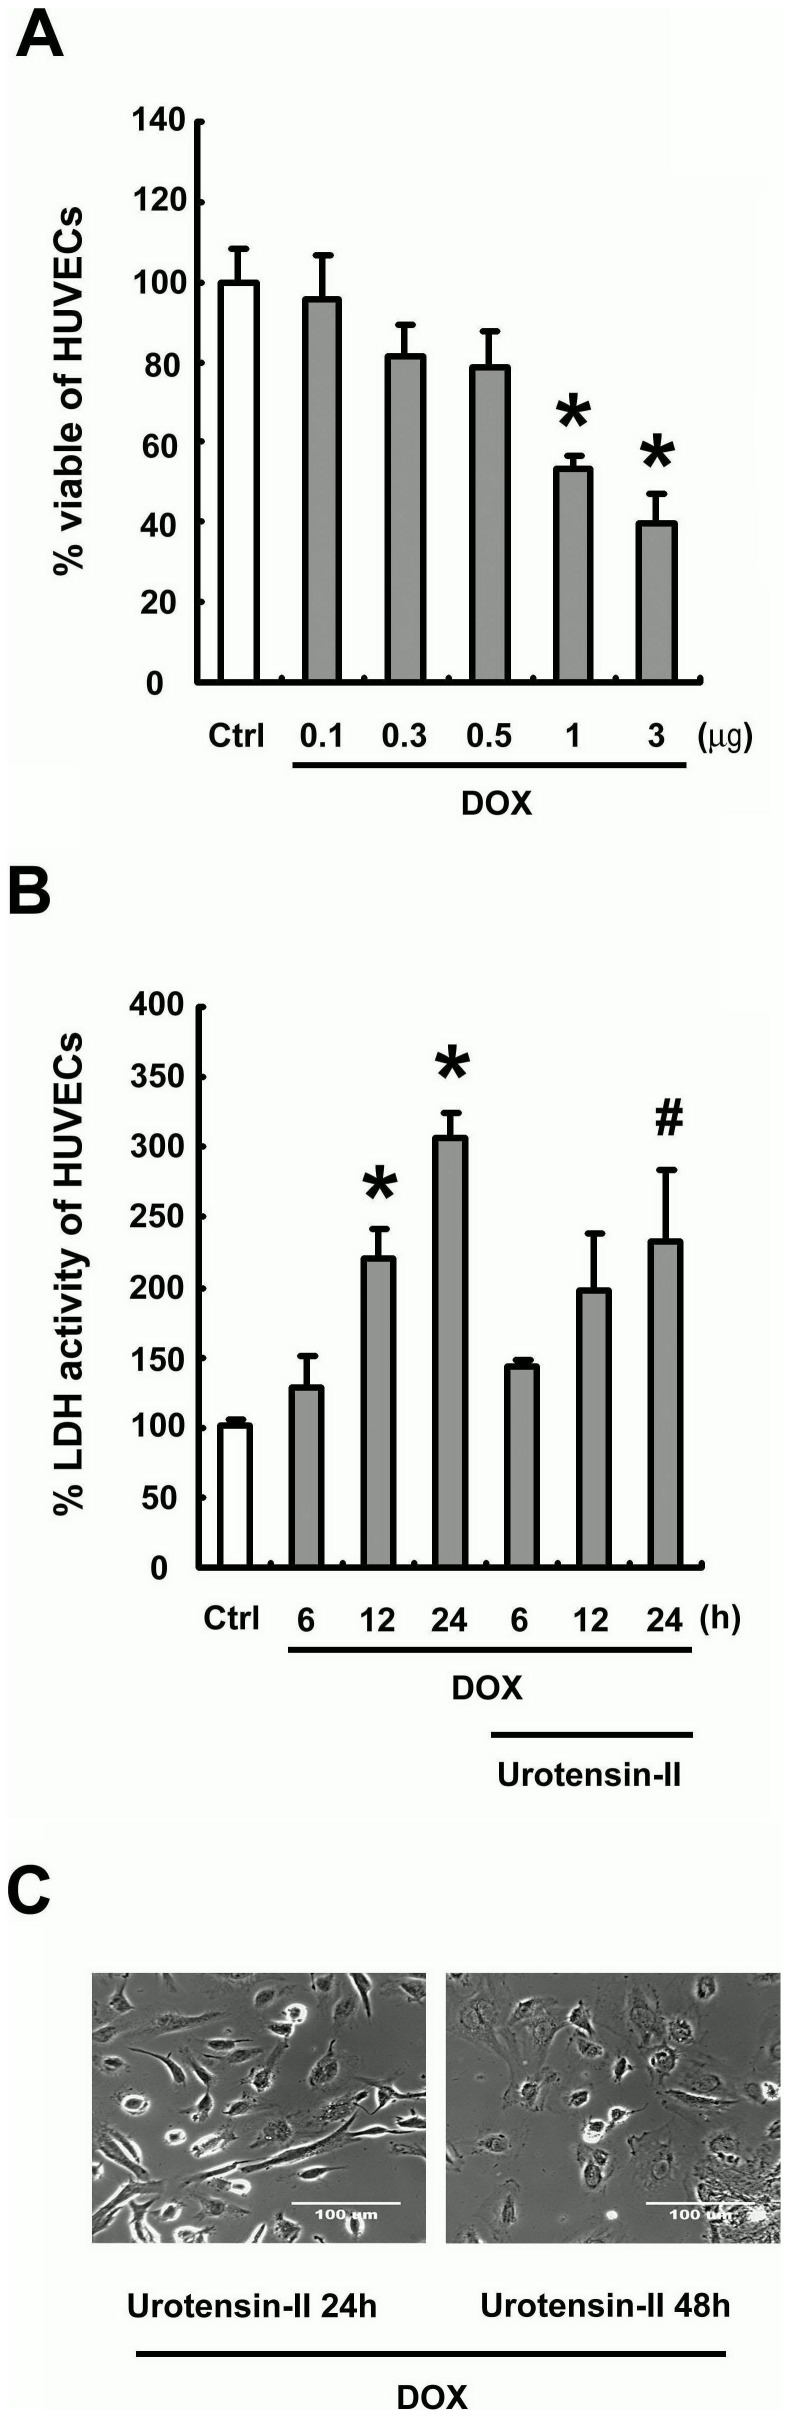
Effect of U-II on DOX-induced cytotoxicity evaluated by 3-[4,5-dimethylthiazol-2-yl]-2,5-diphenyl tetrazolium bromide (MTT) assay (see Methods) (A) 24 h incubation with DOX ranging from 0.1 to 3 µM inhibited the viability of HUVECs in a dose-dependent manner.The average of optical densities at 584 nm in control wells is expressed as 100%. (B) U-II inhibited LDH release from the cells by DOX after 24 h. (C) Photomicrographs from phase-contrast microscopy. Pretreatment with U-II attenuated the cytotoxic effect of DOX when cells were incubated with DOX for 24 h (left), however, the induction of cell death at 48 hr (right). Densitometric data are means ± SEM from three separated experiments. *P <0.05 vs. control (Ctrl); #
P <0.05 vs. DOX treatment.